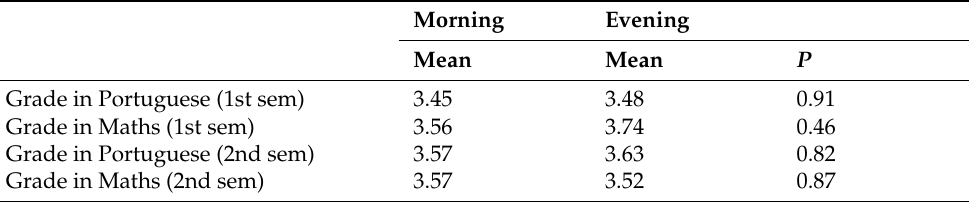
Table 4. Academic performance according to